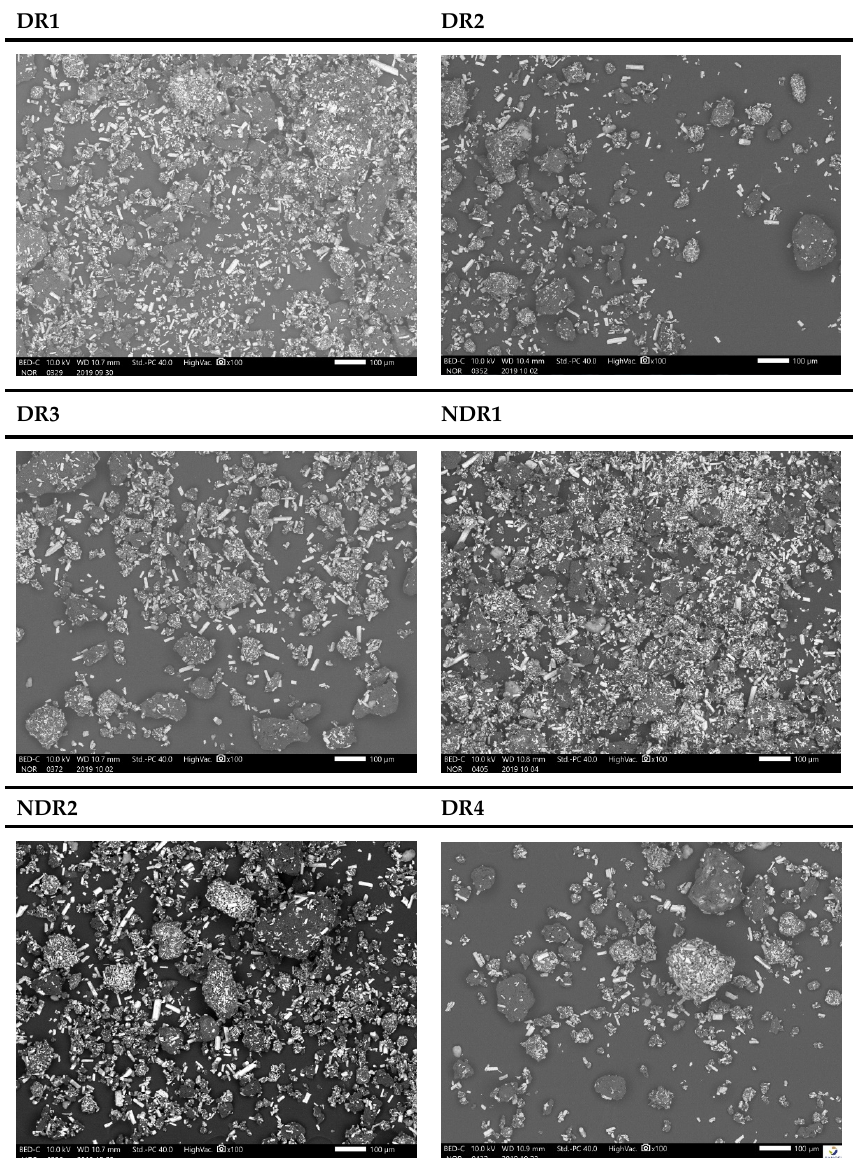
Figure 6. SEM micrographs with × 100 magnification of amiodarone formulations free powders after storage. From the top corner left to the bottom right are presented batches DR1, DR2, DR3, NDR1, NDR2 and DR4.